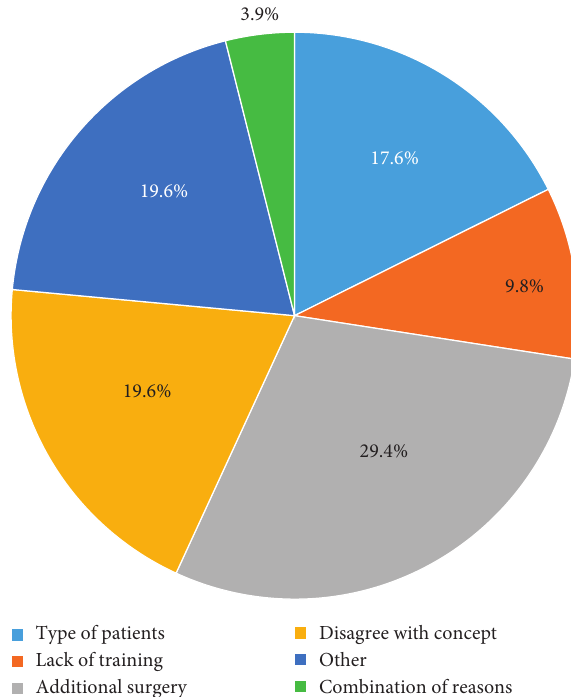
Figure 3: The reasons reported by prosthodontists when imme- diate loading is not